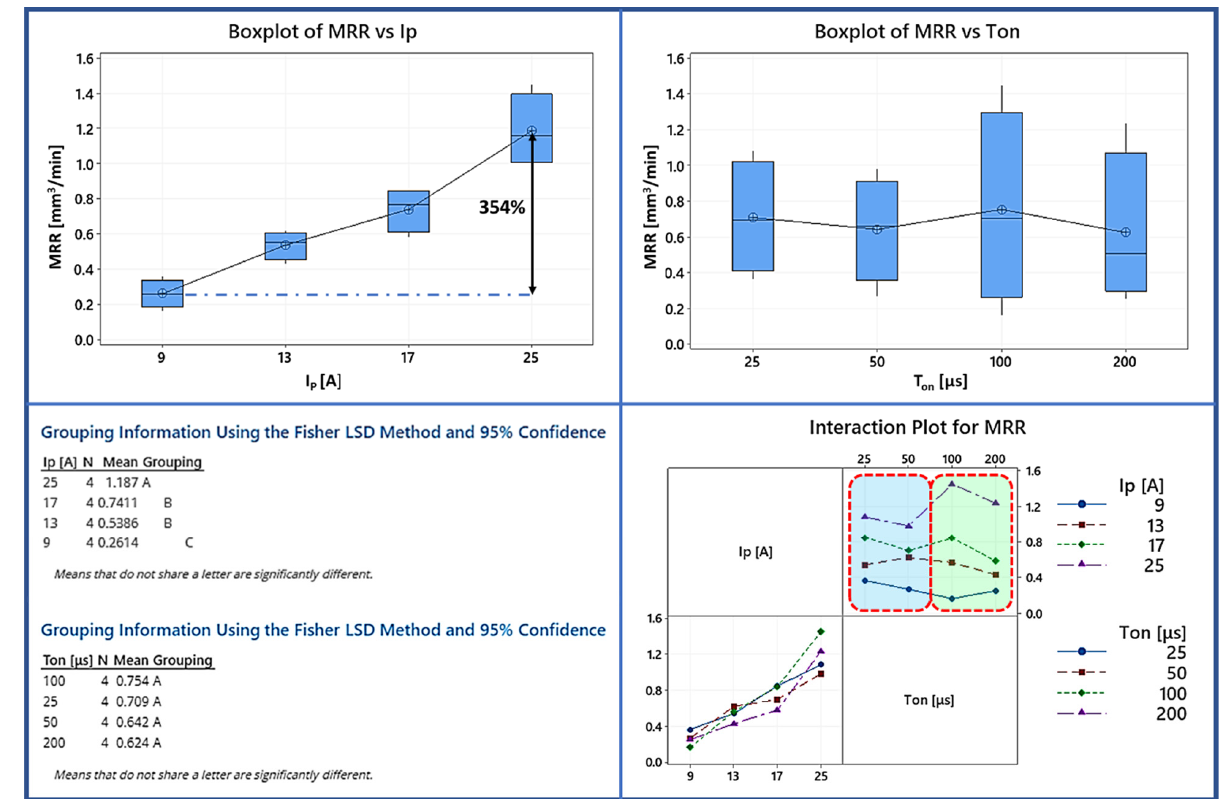
Figure 3. Box plot, interaction plot of MRR and the results of the Fisher statistically significant test.